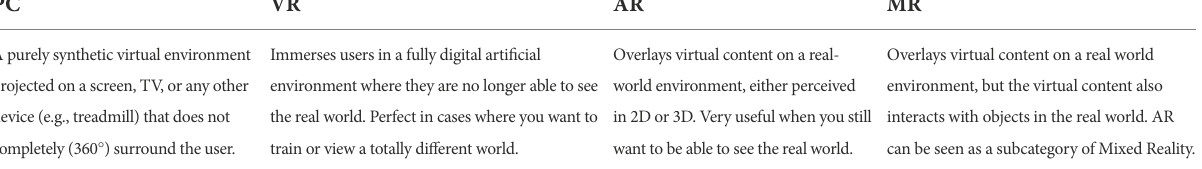
TABLE 1 A short distinction between the terms used to classify digital devices. PC VR